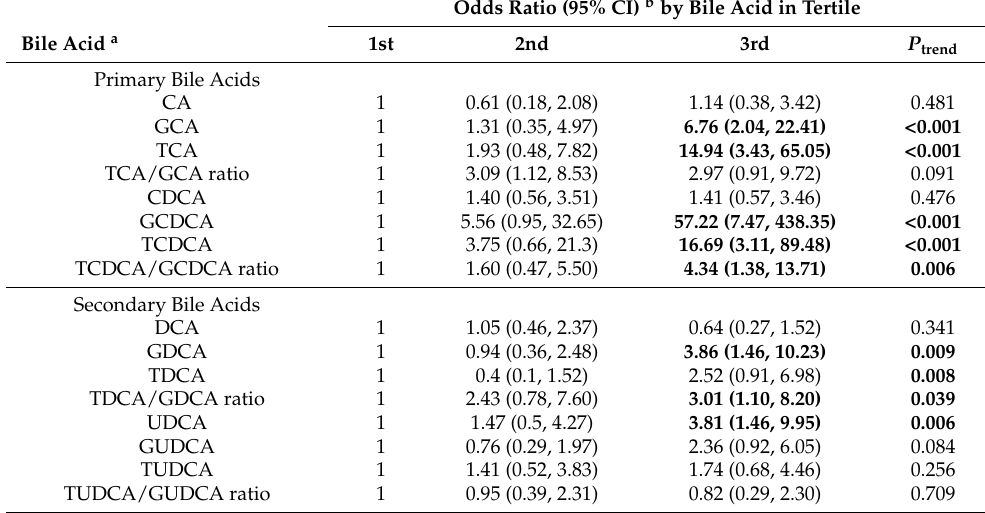
Table 5. Free and conjugated specific bile acids and the molar ratios of taurine-over glycine- conjugated bile acids in relation to risk of developing hepatocellular carcinoma, The Singapore Chinese Health